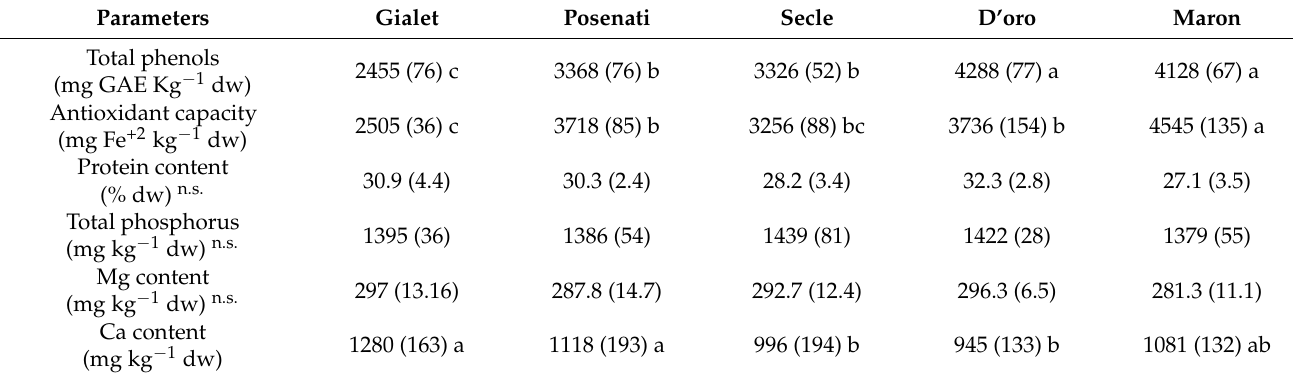
Means followed by different letters in the same row indicate a significant difference between compared local varieties. n.s. = non-significant difference. α = 0.05. The standard deviation is in parenthesis after the values (n = 4). Maron ALS did not produce seeds; thus, it is not represented in the table.